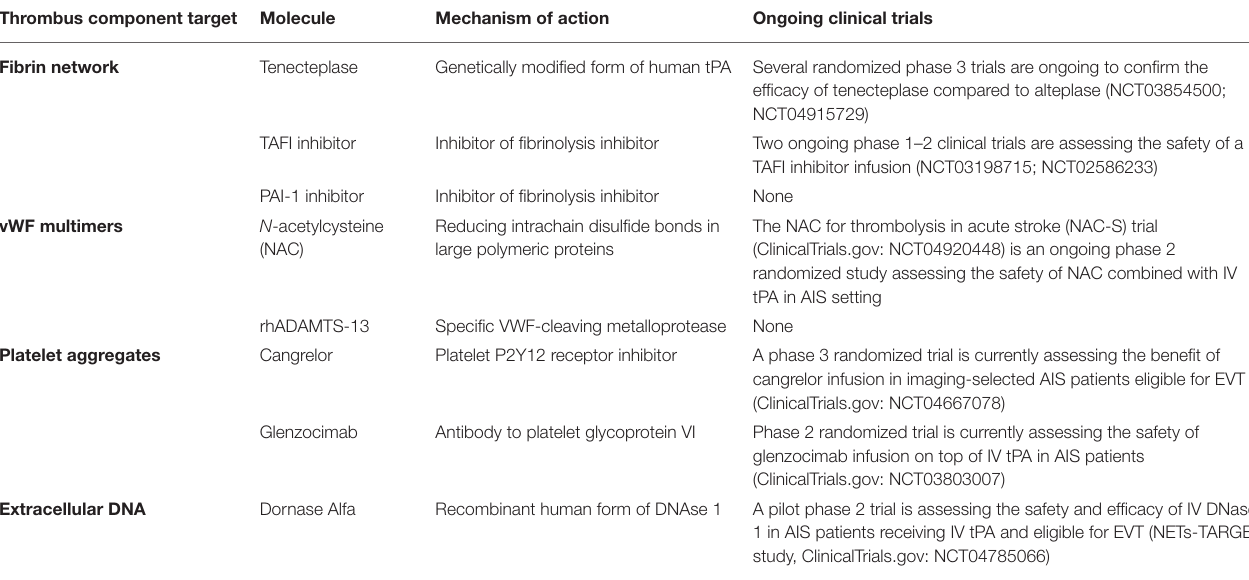
TABLE 1 | Summary of the potential treatment approaches, their mechanisms of action, and ongoing clinical